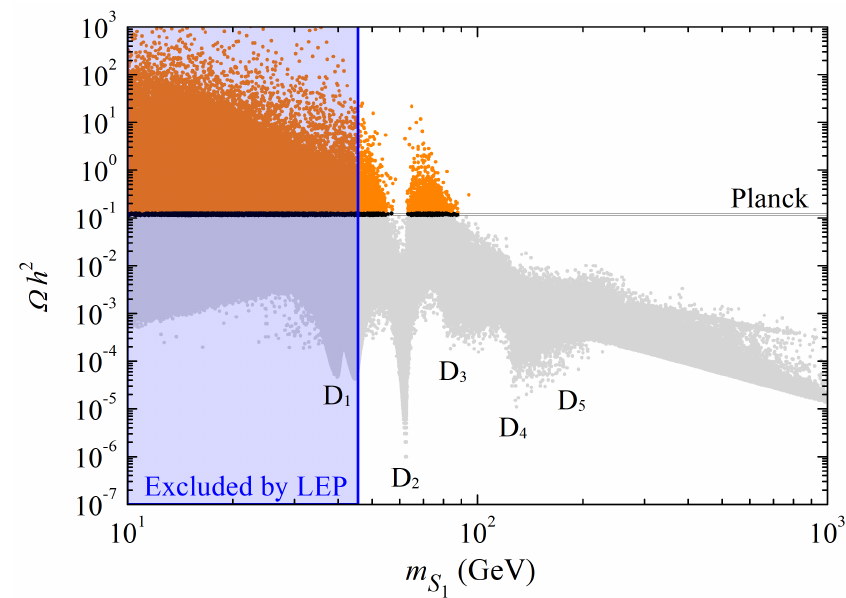
. The black points lie within 1 . The labels (D )-(D ) refer to the 1 1 5